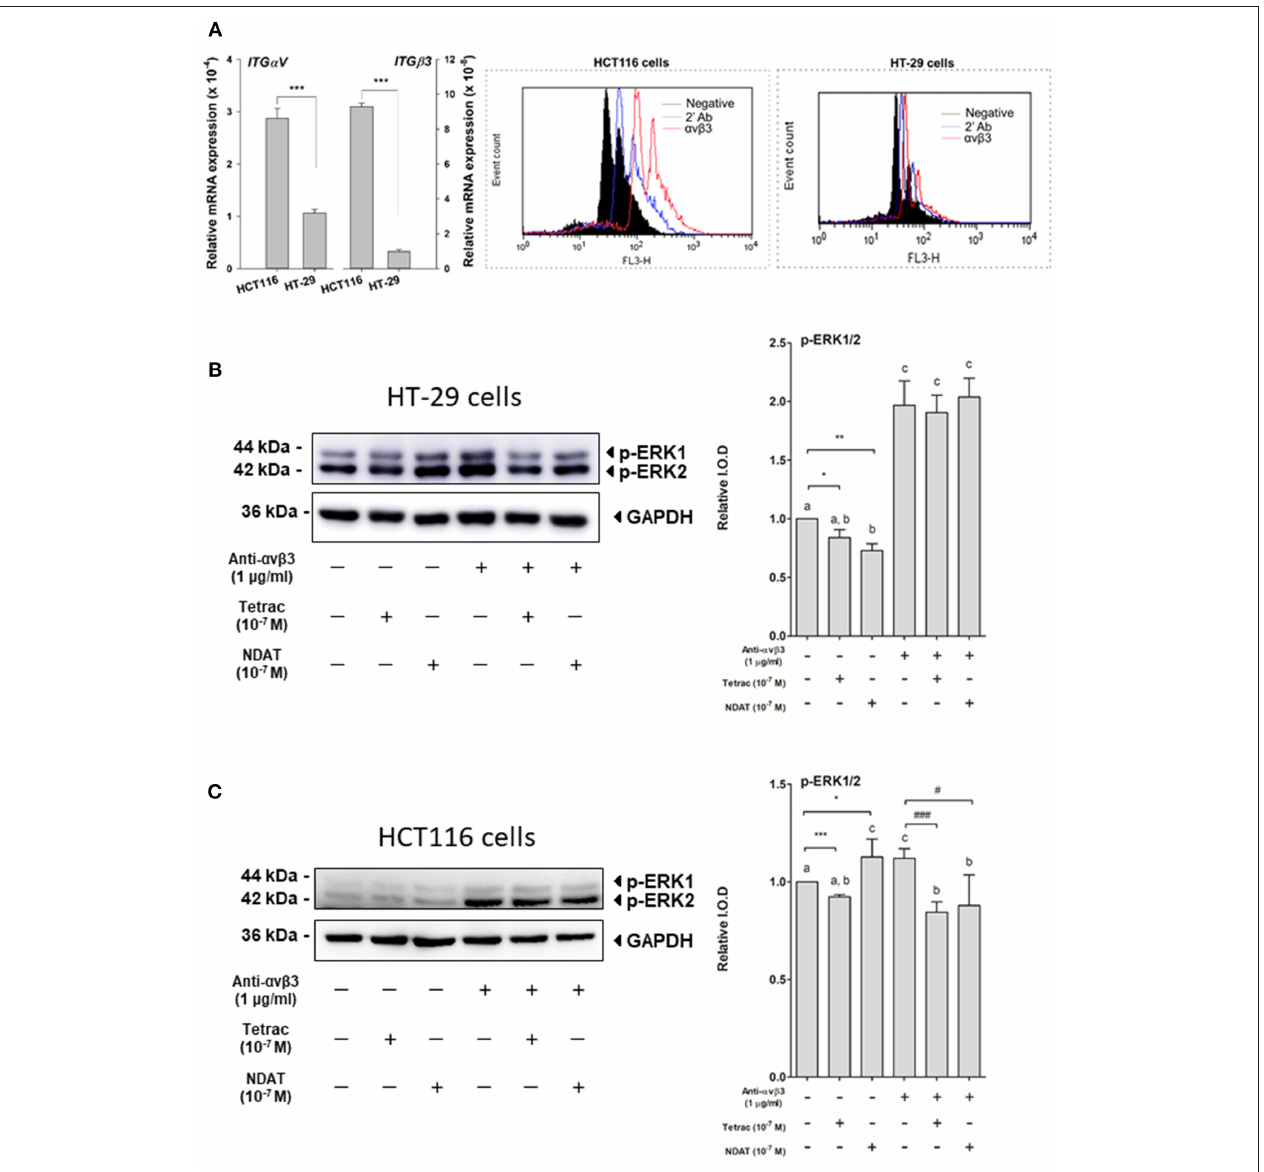
FIGURE 1 | Cell surface integrin α v β 3 is the binding site of tetrac and NDAT in colorectal cancer cells. (A) Eighty-five percent confluent colorectal cancer cells, HT-29 cells, and HCT116 cells, grown in 10-cm Petri dishes were harvested for studies of QPCR and flow cytometry analysis of integrin α v β 3. For studies of ERK1/2 activation, HT-29 cells and HCT116 cells seeded in 10-cm Petri dishes were pretreated with 1 µ g/mL of anti-integrin α v β 3 antibody for 30min and then treated with either 10 − 7 M tetrac or 10 − 7 M NDAT for 30min. Total proteins were extracted, then Western blot analyses were conducted. (B) Activation of ERK1/2 was induced by NDAT but not tetrac in HT-29 cells. (C) . Activation of ERK1/2 was inhibited by tetrac and NDAT in HCT116 cells. Pretreatment of anti-integrin α v β 3 antibody reversed their effects. Number of independent experiments. N = 3. (Data are expressed as mean ± SD; * p < 0.05, ** p < 0.01, *** p < 0.001, compared with untreated control; # p < 0.05, ### p < 0.001, compared with anti-integrin α v β 3 antibody treatment. a-c: the subsets after post hoc analysis after the significant differences were obtained using one-way ANOVA).